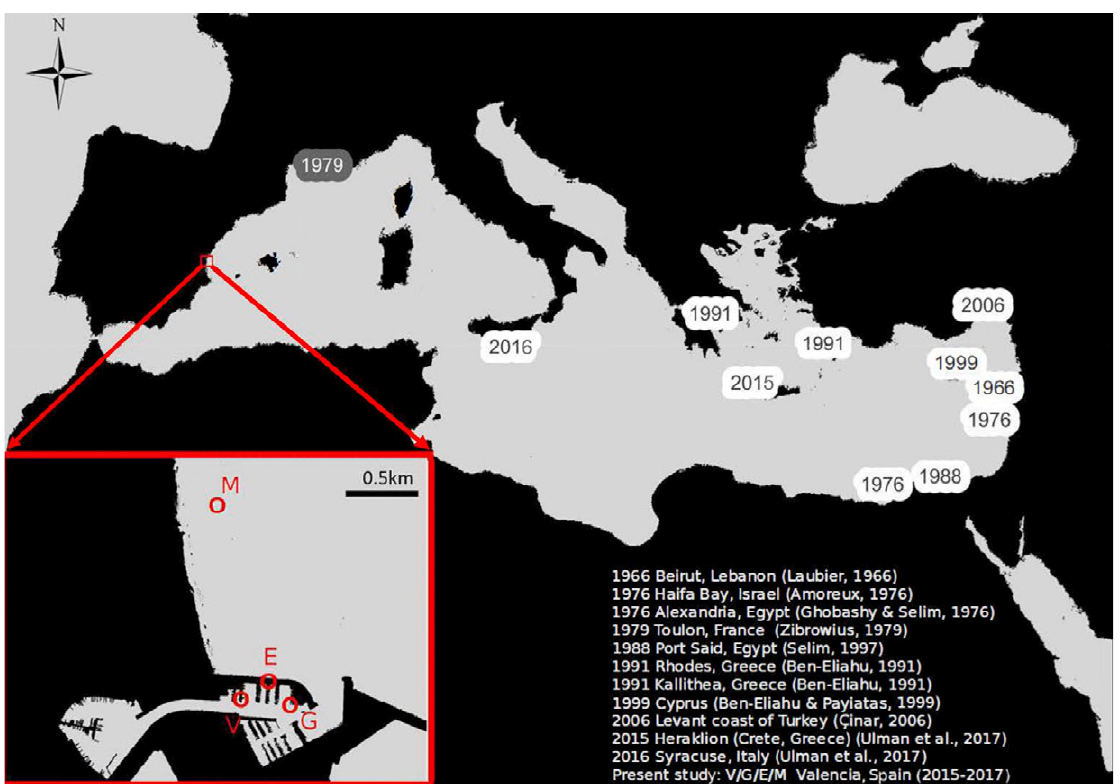
Fig. 1. – Previous records of Spirobranchus cf . tetraceros from the Mediterranean Sea and location of the new records reported in this study (red rectangle). Sampling sites (red circles) at the Malvarrosa beach artificial reef (M) and within the Valencia Port: gas station (G), sailing school (V) and breakwater (E). White labels represent the recorded year of established populations, the grey label represents a hull-fouling record (Toulon, France). Map image edited with gvSIG (http://www.gvsig.com/es/inicio) and GIMP (https://www.gimp.org)